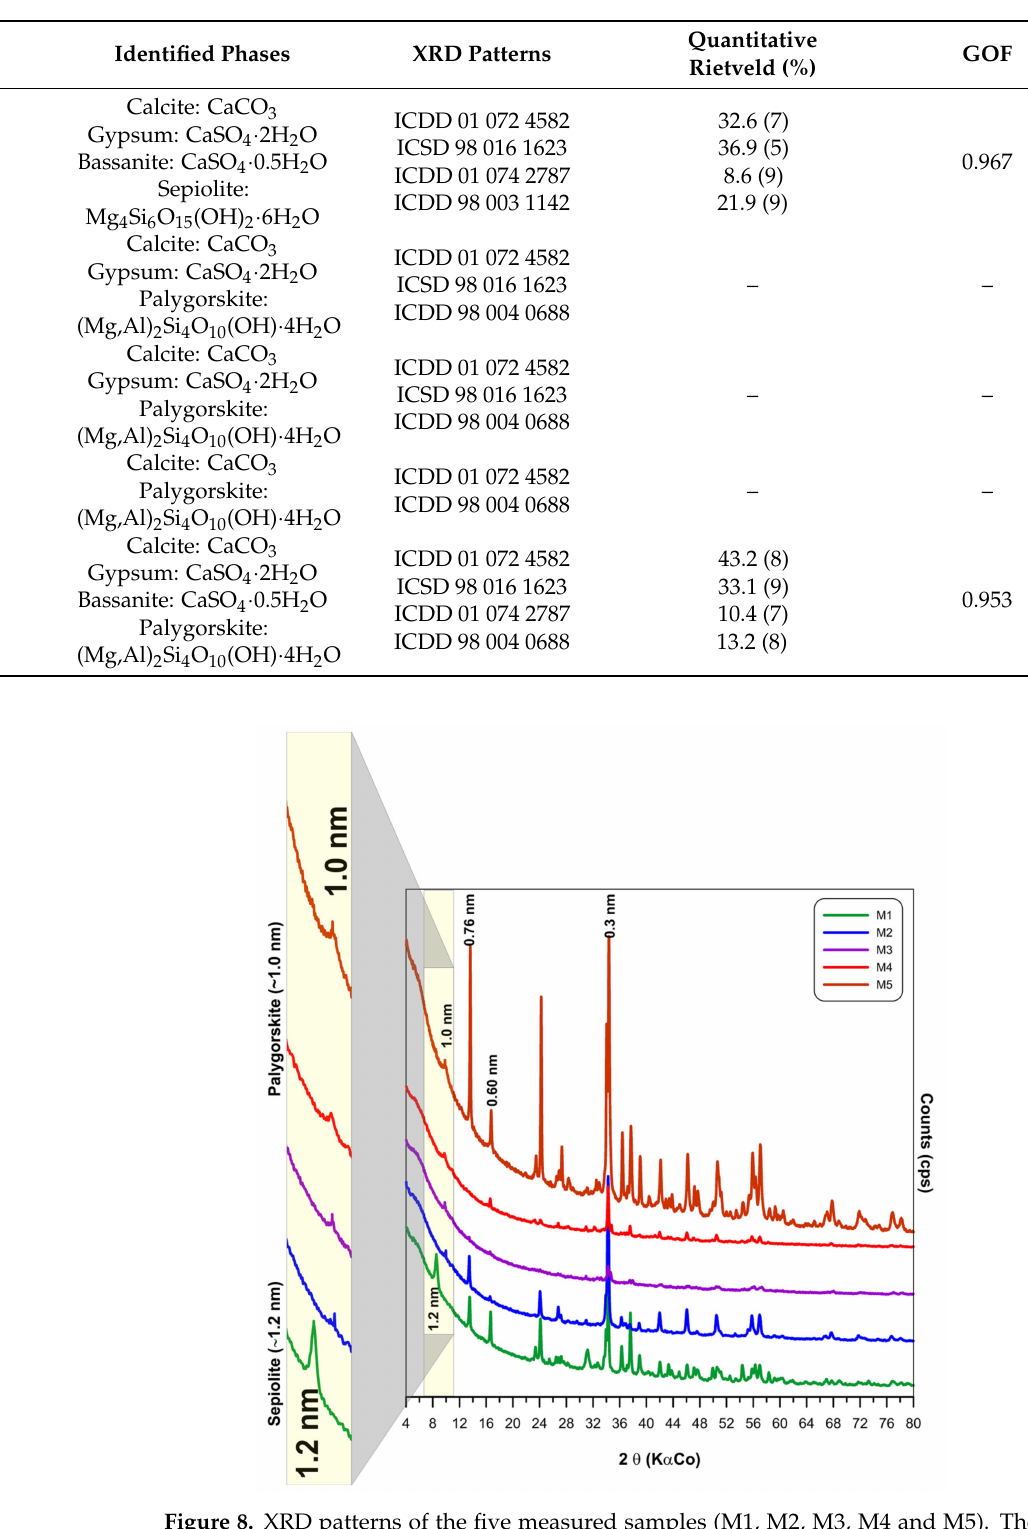
Table 5. XRD results. Quantitative results by Rietveld method could only be obtained for samples M1 and M5. GOF = goodness of fit. IMA (International Mineralogical Association) approved formulas of minerals (http://cnmnc.main. jp/) are indicated.